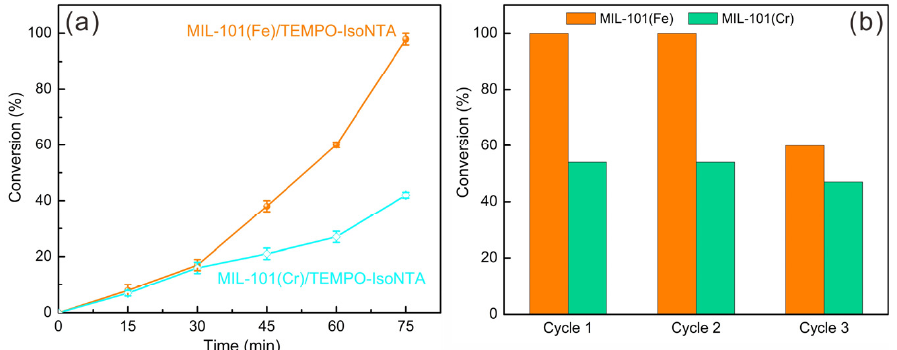
Figure 4. ( a ) Kinetic curves of benzyl alcohol to benzaldehyde by MIL-101(Fe)/TEMPO-IsoNTA (orange line) and MIL-101(Cr)/TEMPO-IsoNTA (light blue line) under identical reaction conditions; ( b ) catalytic conversion of benzyl alcohol catalyzed by MIL-101(Fe) (orange column) and MIL-101(Cr) (green column) during three runs.